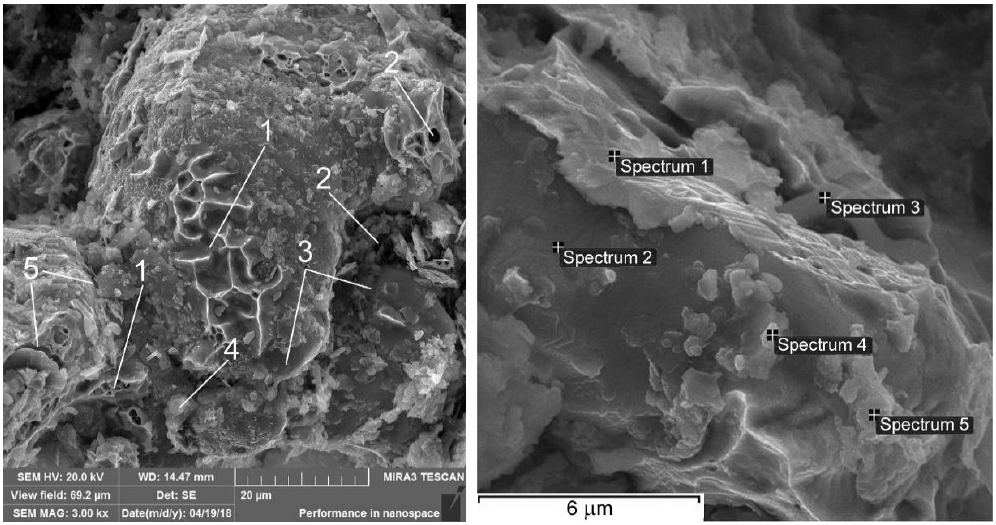
Figure 10. Fractographies of FeGr1 with 1 wt% SiC particulates: 1—trans-crystalline quasi-brittle fracture areas; 2—pores; 3—brittle cleavage areas; 4—SiC particulate; 5—microcracks. Table 3. Results of the SEM analysis of the fractural submicroarea of FeGr1 + 1 wt% of silicon carbide. Number of Spectrum C,